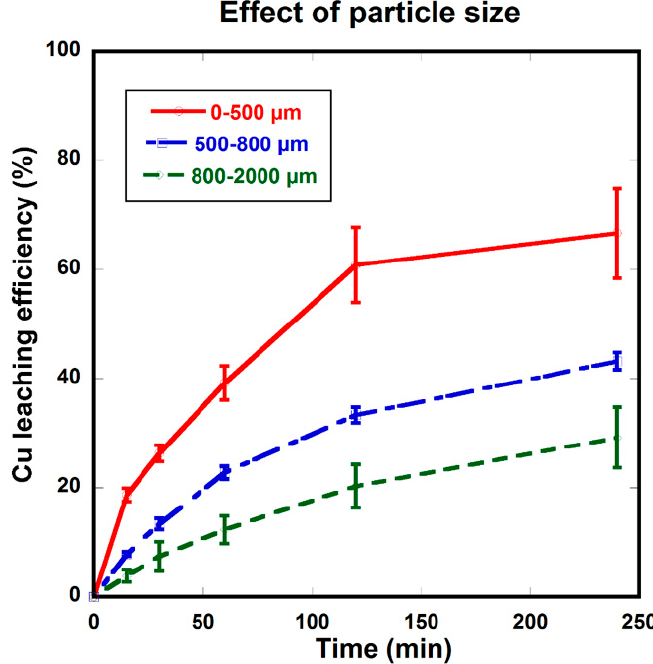
Figure 1. E ff ect of particle size (Ferric sulfate—50 mM, temperature—20 ◦ C, agitation—150 rpm, and pulp density—10 g · L − 1 Figure 1. Effect of particle size (Ferric sulfate—50 mM, temperature—20 °C, agitation—150 rpm, and pulp density—10 g·L − 1 ).